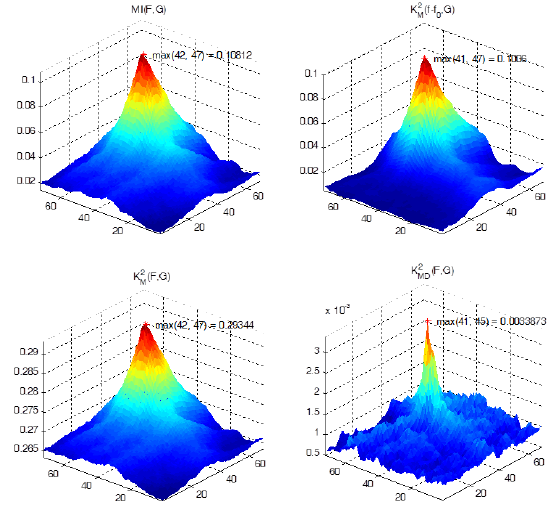
Figure 3. Example 1: a) etalon TV fragment; b) test IR image; c) segmented TV fragment.